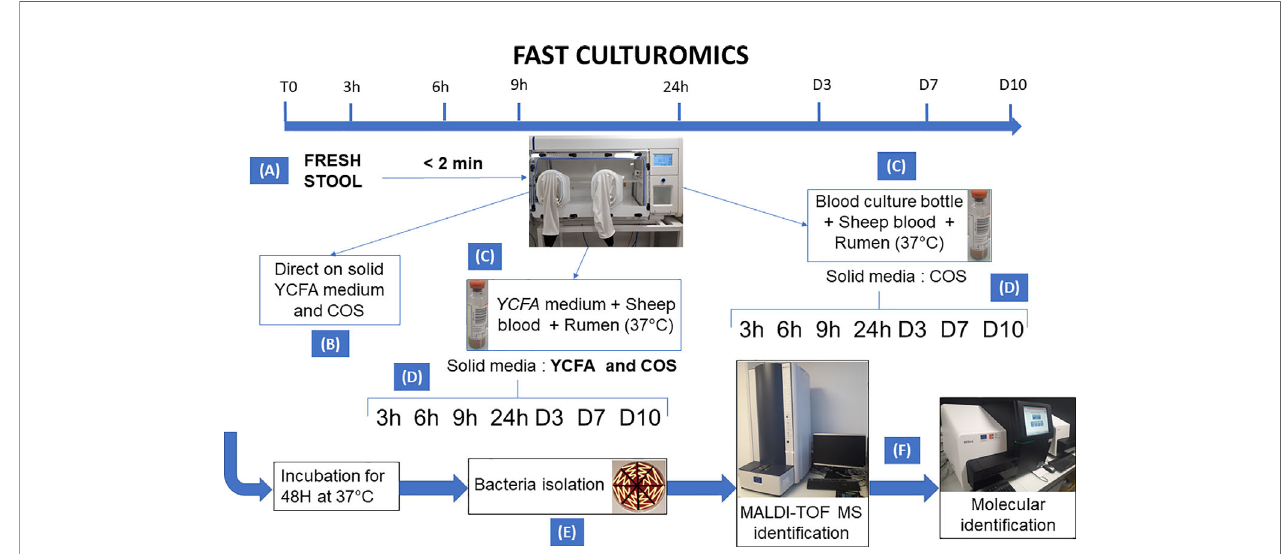
FIGURE 1 | Summary of the methodology of fast culturomics. The fast culturomics was based on six main steps: (A) Sampling: Sampling of samples was carried out in anaerobic conditions. For this purpose, the stool sample was placed in a half-open jar, itself placed in anaerobic condition in a zip bag complemented by an anaerobic generator. The assembly was then directly transferred to an anaerobic chamber, after less than 2 min of exposure to oxygen. (B) Direct inoculation: direct inoculation of the stool sample was carried out on both blood agar (COS) and YCFA agar. (C) Pre-incubation in liquid medium: The sample was pre-incubated in two liquid culture media at 37°C: the commercially available Biomerieux medium and the YCFA medium, both supplemented with 5% sheep blood and 5% rumen fi ltered at 0.22 µm. (D) Inoculation of blood culture bottles on agar: At the different pre-incubation times (3h-6h-9h-24h-D3-D7-D10), a serial dilution of pre-incubated blood culture bottles was performed. Both bottles were inoculated onto blood agar (COS), but only the YCFA+rumen+blood culture condition was also deposited on YCFA agar. (E) Subculturing of colonies: Microbial colonies was subcultured after 48 h incubation of the agar at 37°C. This subculturing was carried out according to the different aspects of the microbial colonies obtained. (F) Identi fi cation: the identi fi cation of the microbial species was carried out by Matrix Assisted Laser Desorption Ionization/Time Of Flight Mass Spectrometry (MALDI-TOF) mass spectrometry. If the target species remain unidenti fi ed three times, the identi fi cation was achieved by molecular